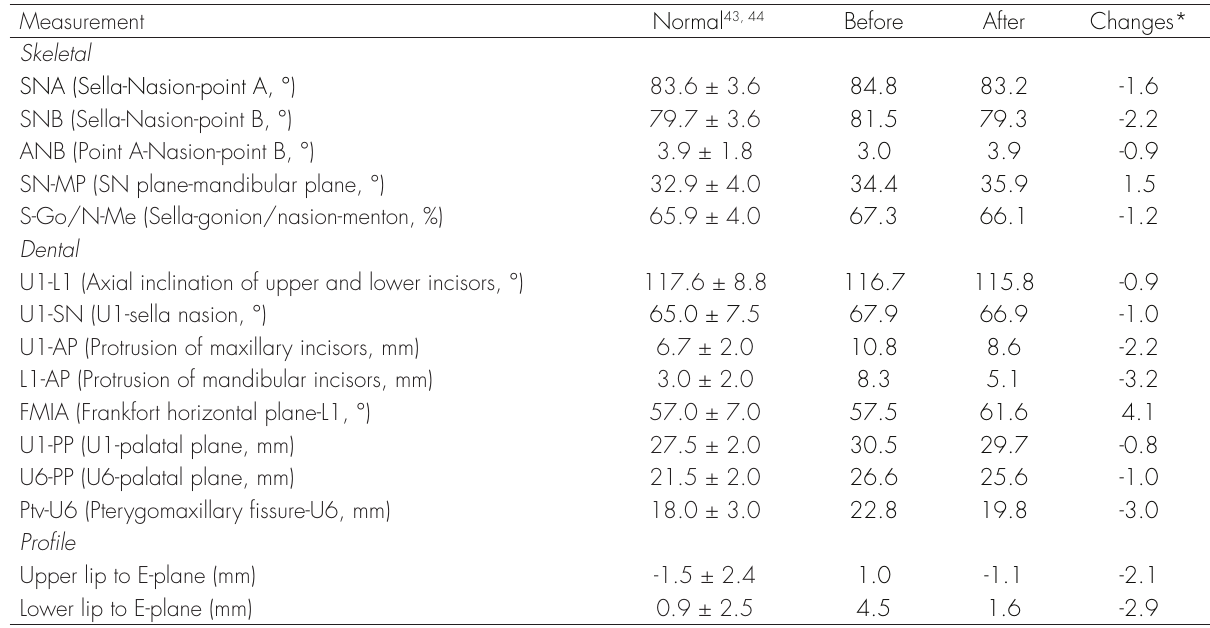
Table I. Cephalometric analyses before and after the treatment.